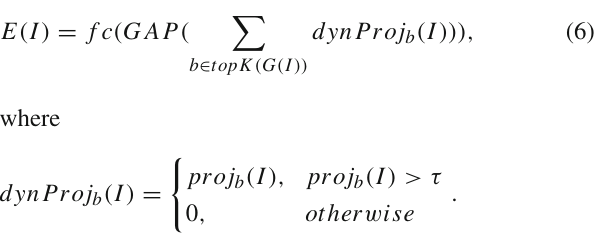
Fig. 3 DynK-Hydra architecture. As described in [5], the branches and the gater are sharing a common set of convolutional layers. The parameter d specifies the number of times a block is replicated. As opposed to [5], we are adding classification layers on top of each